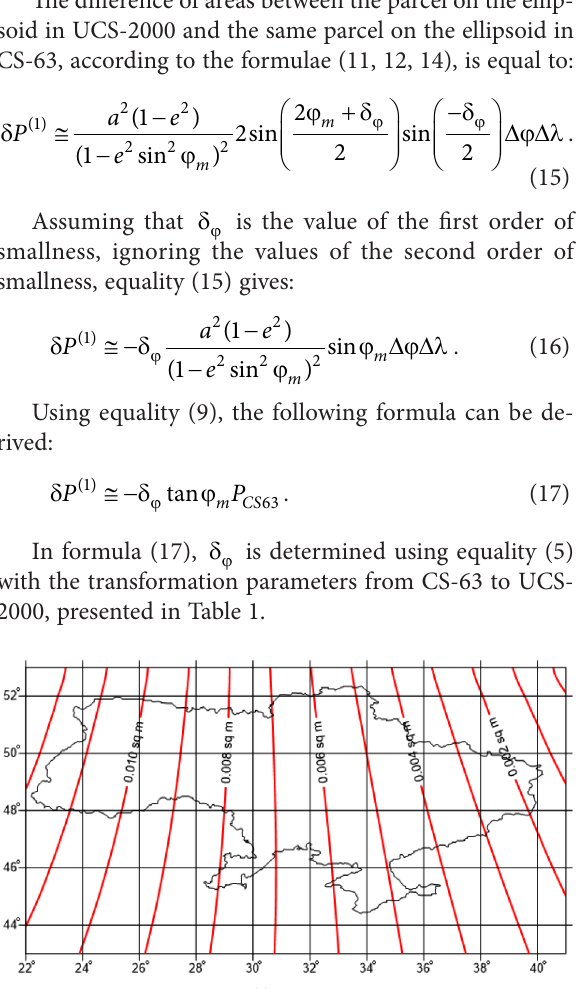
Figure 1. Isolines of (1) dP , calculated for the parcels of 1 hectare for the territory of